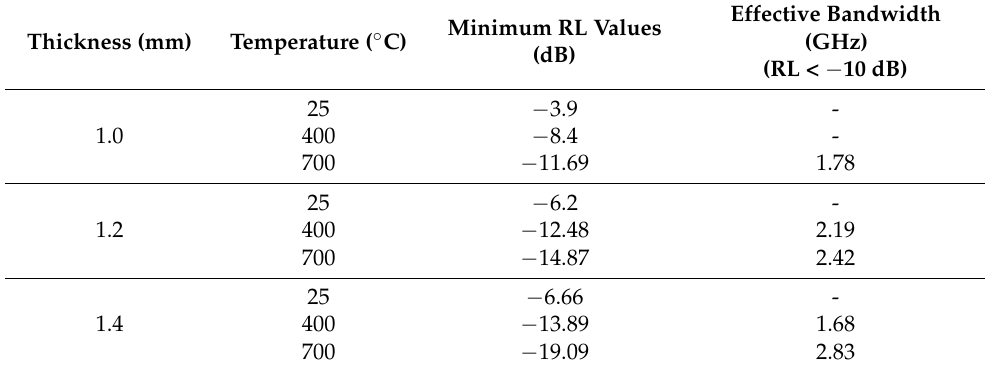
Table 3. Different coatings thickness at different temperatures, RL values, and